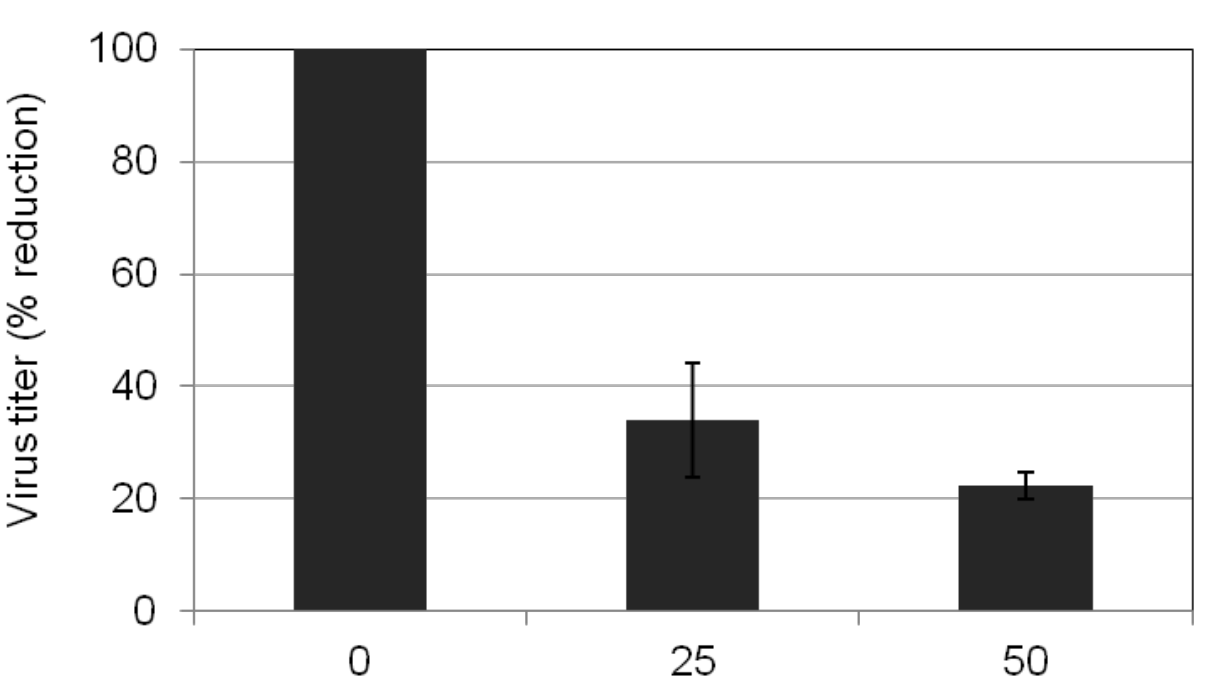
Figure 6. Triple combination of Primula (supercritical CO 2 + 13% EtOH), Cistus (hydroethanolic), and Echinacea (EtOH/H 2 O-Xad7-derived) extracts reduce influenza virus propagation. MDCK cell cultures were infected with H1N1 at MOI = 0.01 in the absence or presence of 25 µ g/mL or 50 µ g/mL each plant extracts before, during, and after infection. Supernatants from each infected culture were assayed for progeny virus yields at 24 h post-infection by measuring plaque formation. Virus